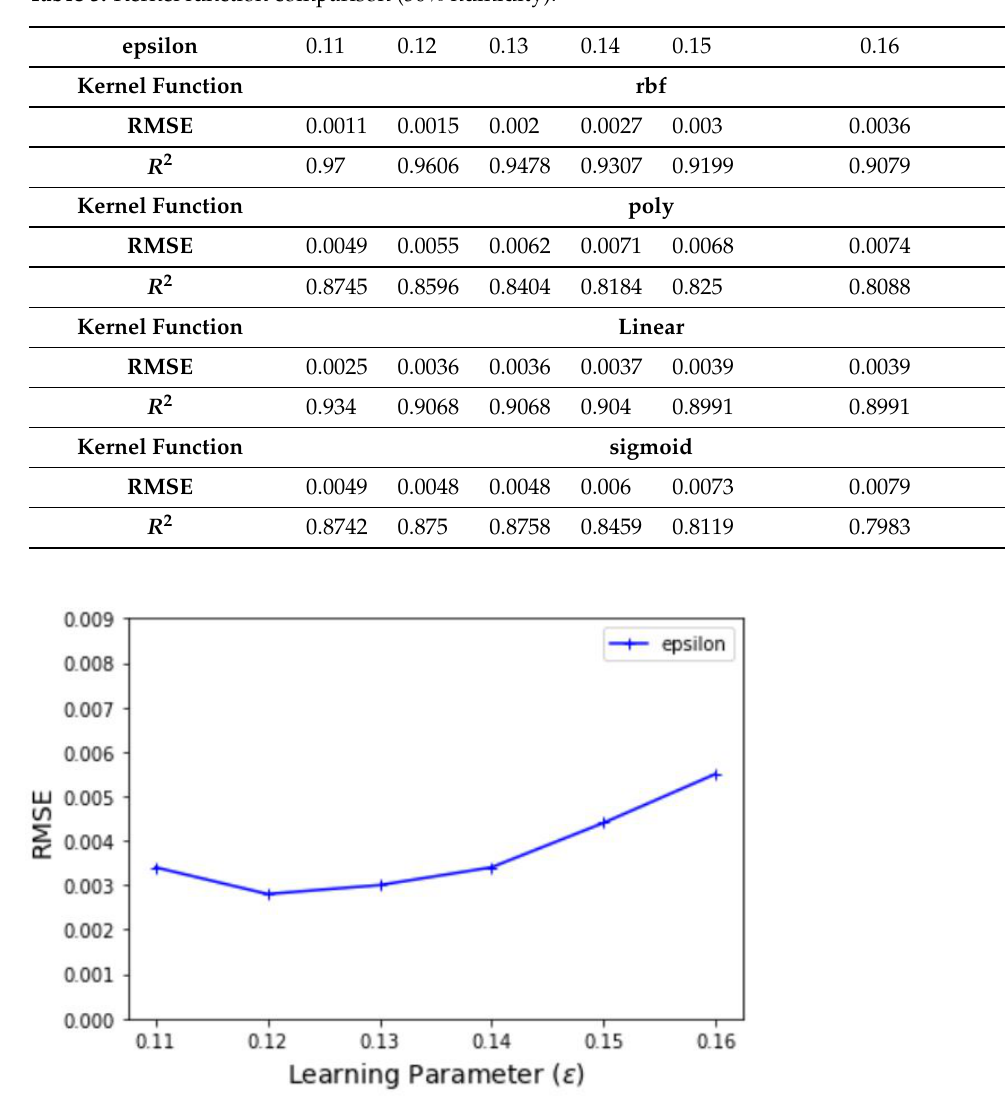
Table 5. Kernel function comparison (50% humidity).